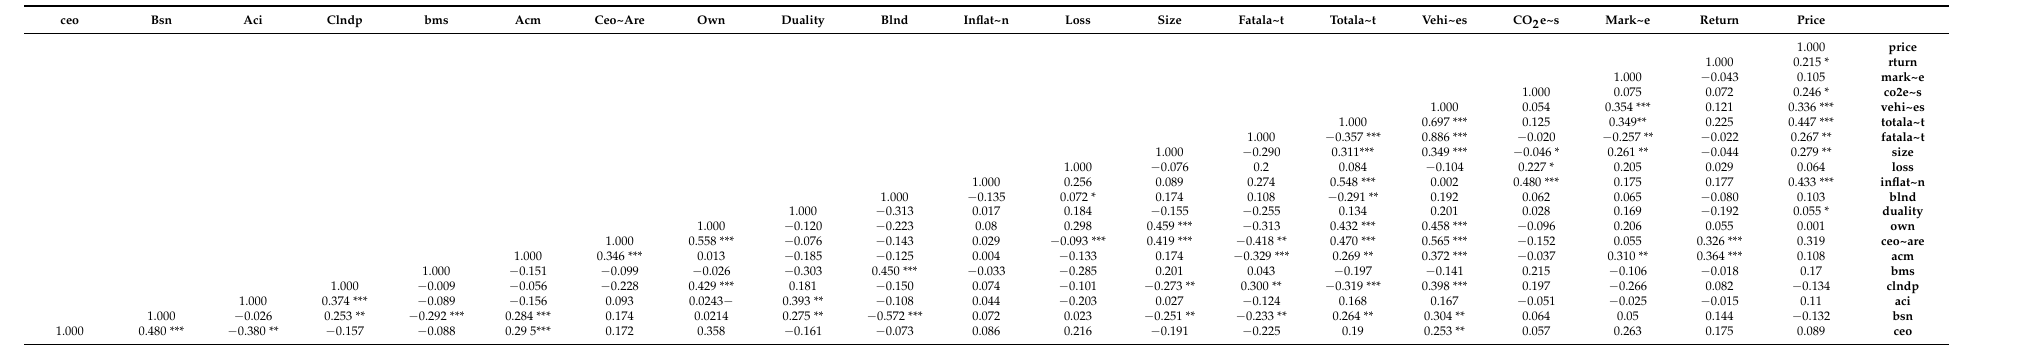
Table 4. Correlation matrix